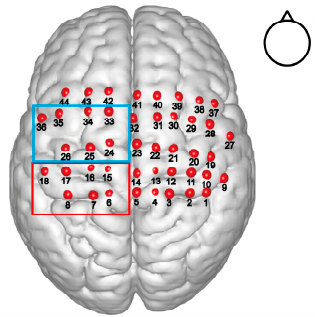
Figure 2. Three-dimensional location of each channel. We used NFRI fNIRS tools incorporated in NIRS-SPM to calculate the spatial registration of each channel from real space to MNI (Montreal Neurological Institute templates) coordinates and plotted them on the standard brain. We considered channels 6, 7, 8, 15, 16, 17, and 18 (red box) as the region of contralateral BA4 and channels 24, 25, 26, 33, 34, 35, and 36 (blue box) as the region of contralateral BA6 based on the probabilistic registration.